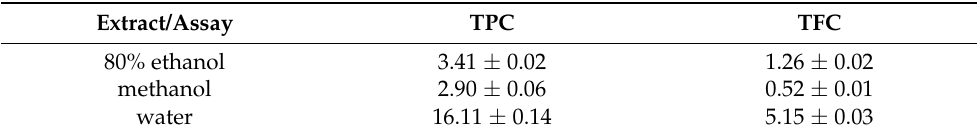
Table 2. Total phenolic content (TPC, mg GAE/g DW) and total flavonoid content (TFC, mg QE/g DW) of T. versicolor NBIMCC 8939